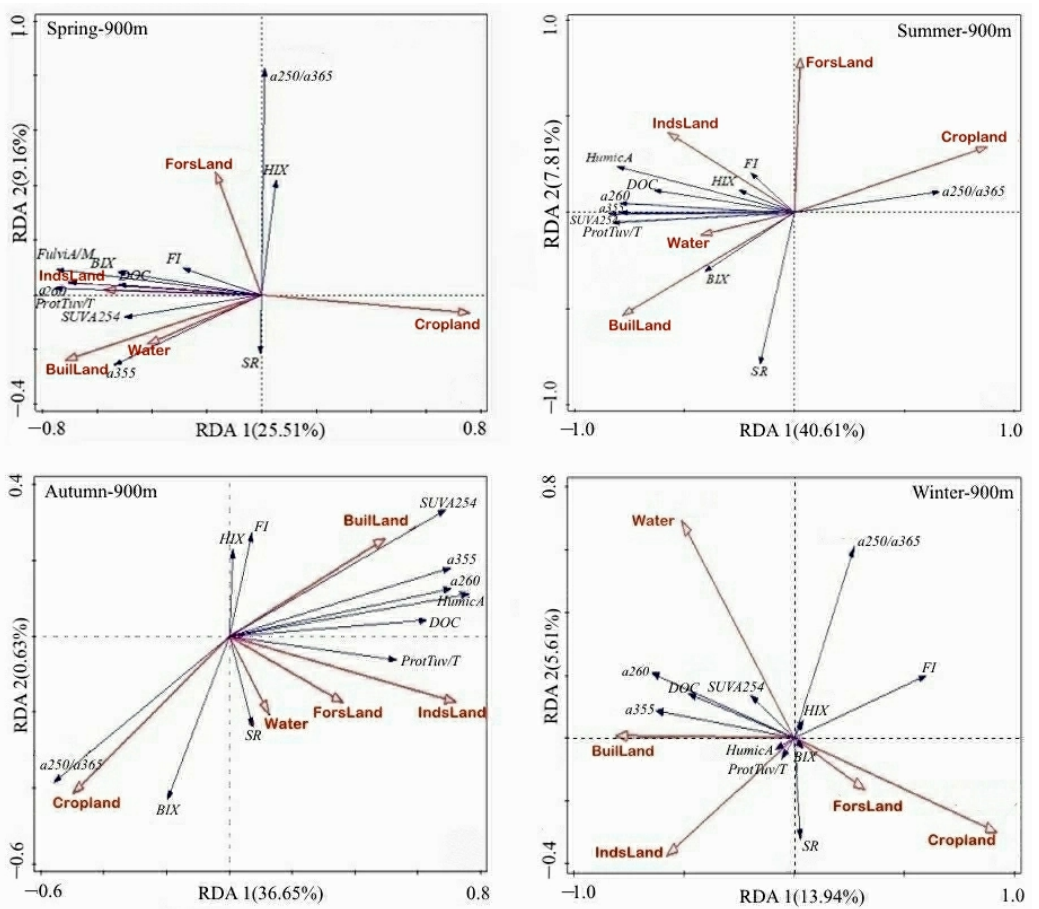
Figure 6. Redundancy analysis (RDA) of the correlation between multiple land use types and CDOM − specific UV absorption coefficient, and the fluorescence peak intensity in the riparian buffer zones of 900 m.